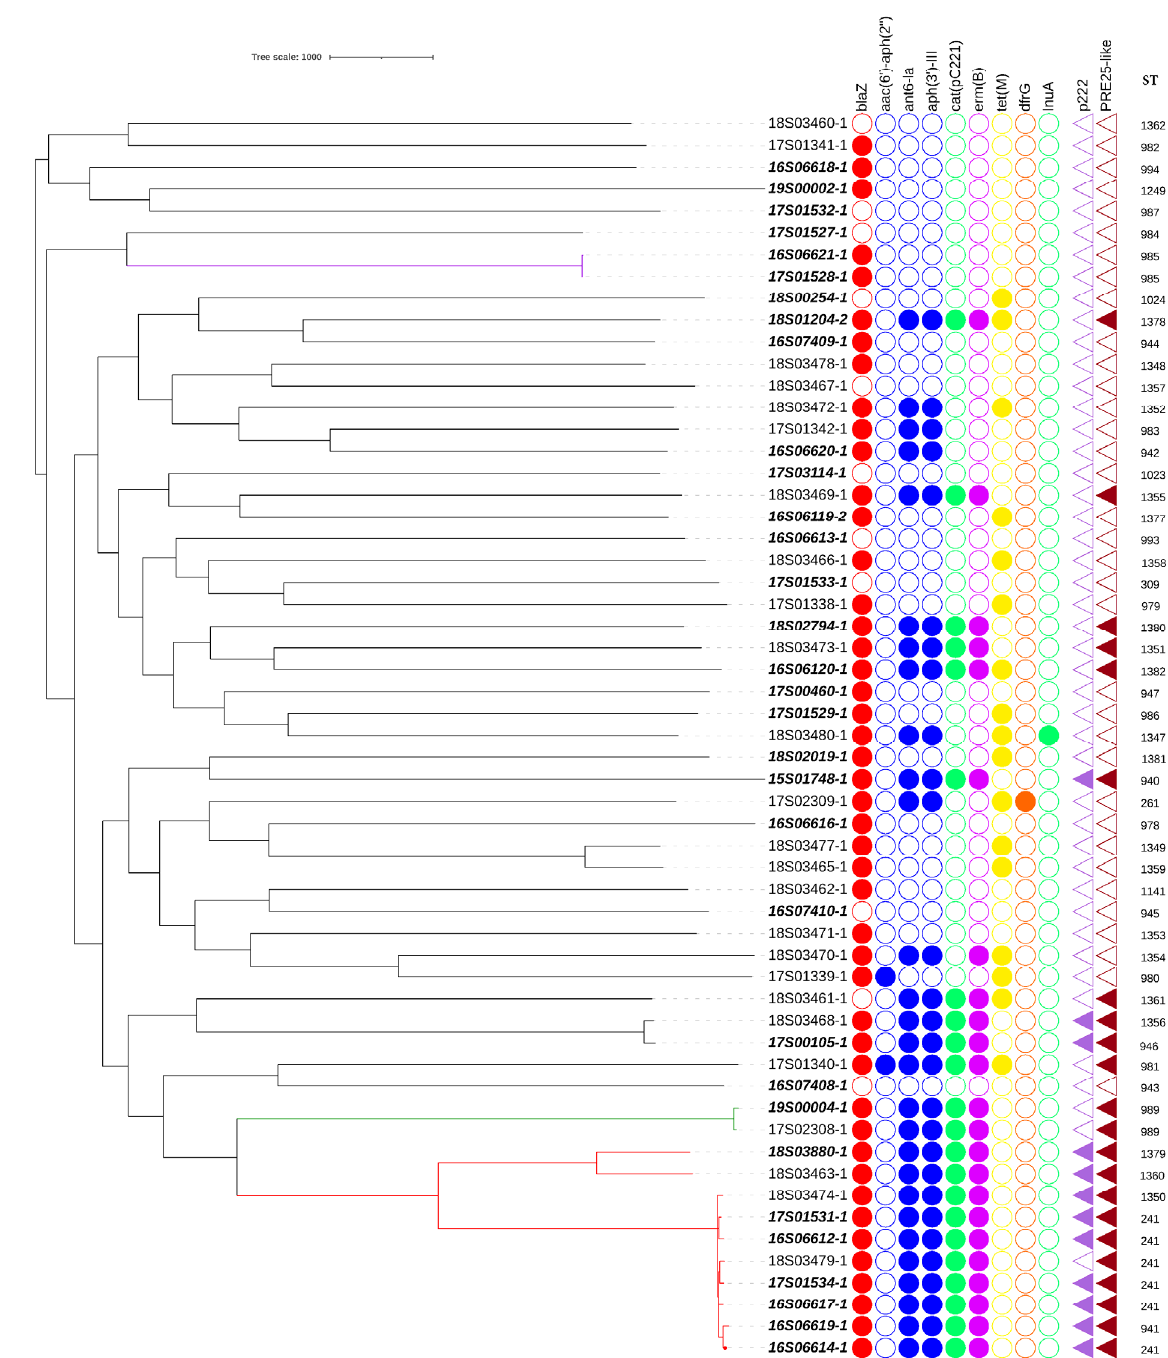
Figure 2. Isolate phylogeny and antimicrobial resistance genes.